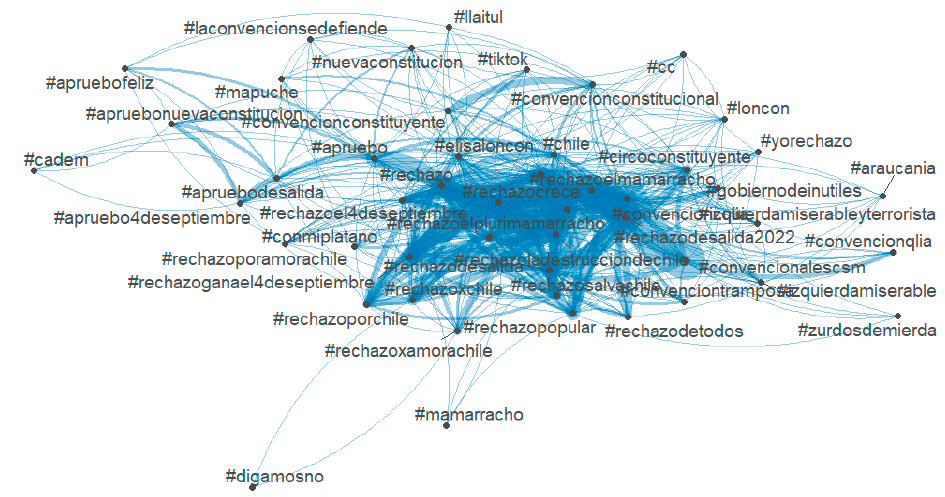
Figure 5. Network of hashtags with hate speech for Pueblos Originarios 2022.